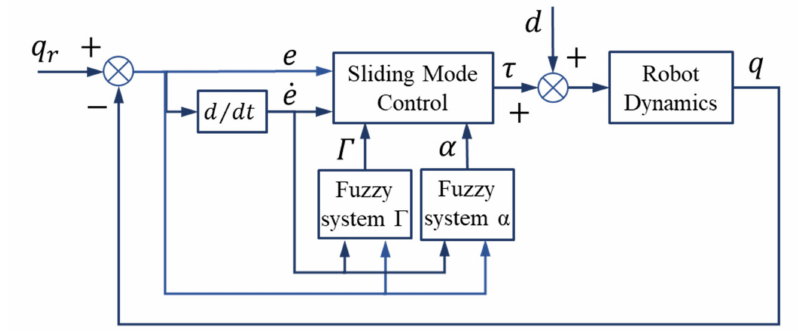
Figure 8. FSMC with adaptive slope α and control gain Γ .